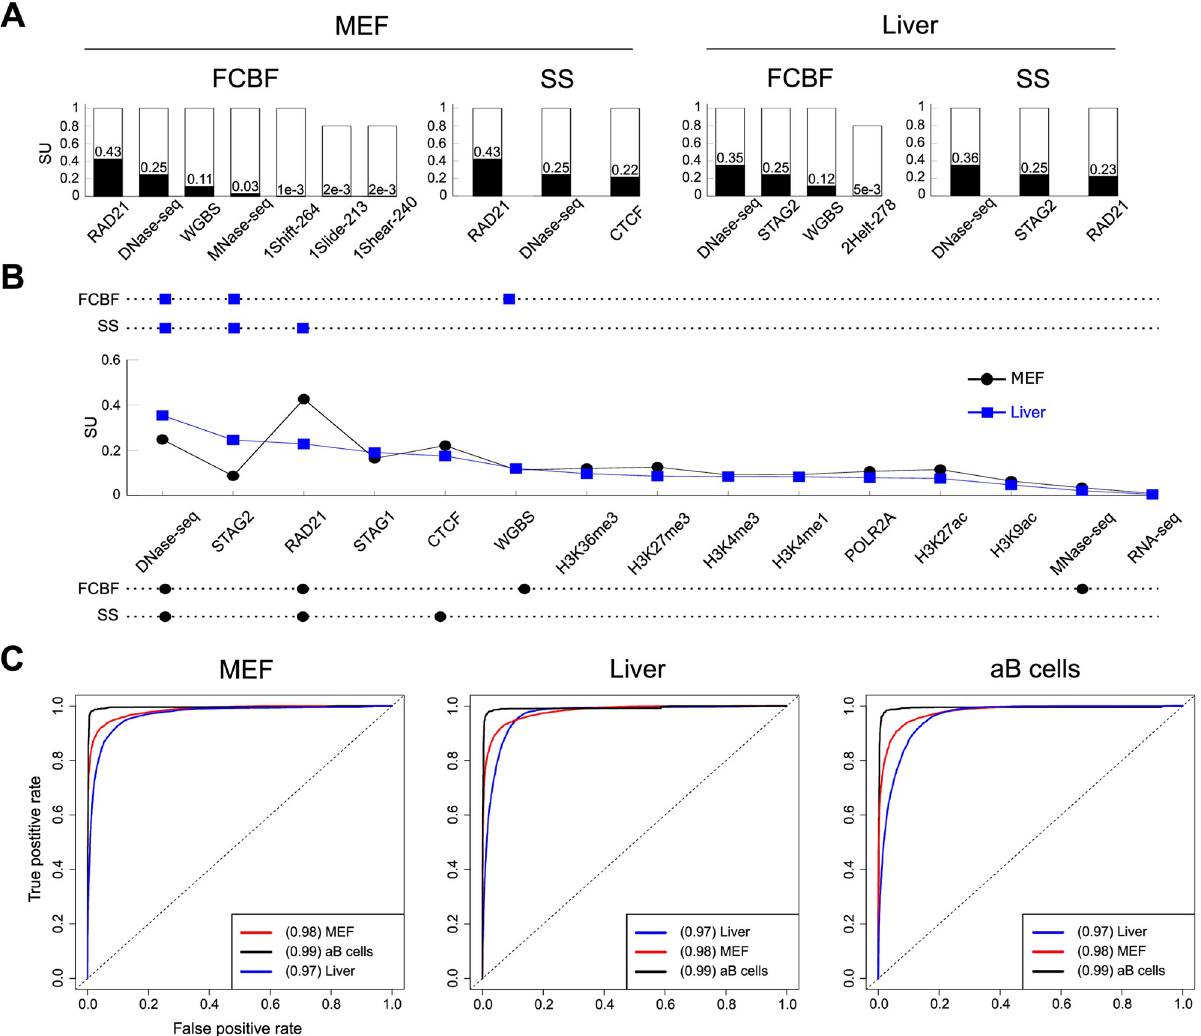
Fig 4. Three features accurately predict TOP2B. A . Top features selected by Fast Correlation Based Filter and Scatter Search algorithms. For each histogram and feature, the white bar height indicates the frequency of selection and the black bar height is the Symmetrical Uncertainty (SU) value with respect to the class (TOP2B). Indexes of DNA shape parameters indicate position within the corresponding parameter vector associated to the 300 bp width of modeled TOP2B binding sites (see Materials and methods). B . Summary of the most selected features by both algorithms. Top and bottom aligned dots indicate selection of a given feature by the corresponding selection algorithm in liver and MEFs, respectively. In the middle, the SU of each feature is displayed. Only the top fifteen features according to their SU are shown, which happen to match in both systems. C . ROC curves and AUC values for Naive Bayes models trained on either MEF, liver or activated B cells and applied to the three systems (for Support Vector Machine and Random Forests models, see S4 Fig). Only DNase-seq, RAD21 and CTCF binding data were used for training.